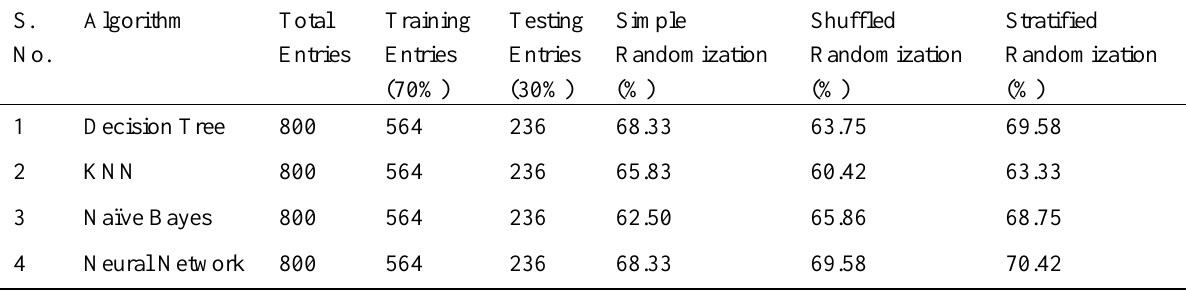
Comparison of the machine learning algorithms applied for intended crowd behaviour S.